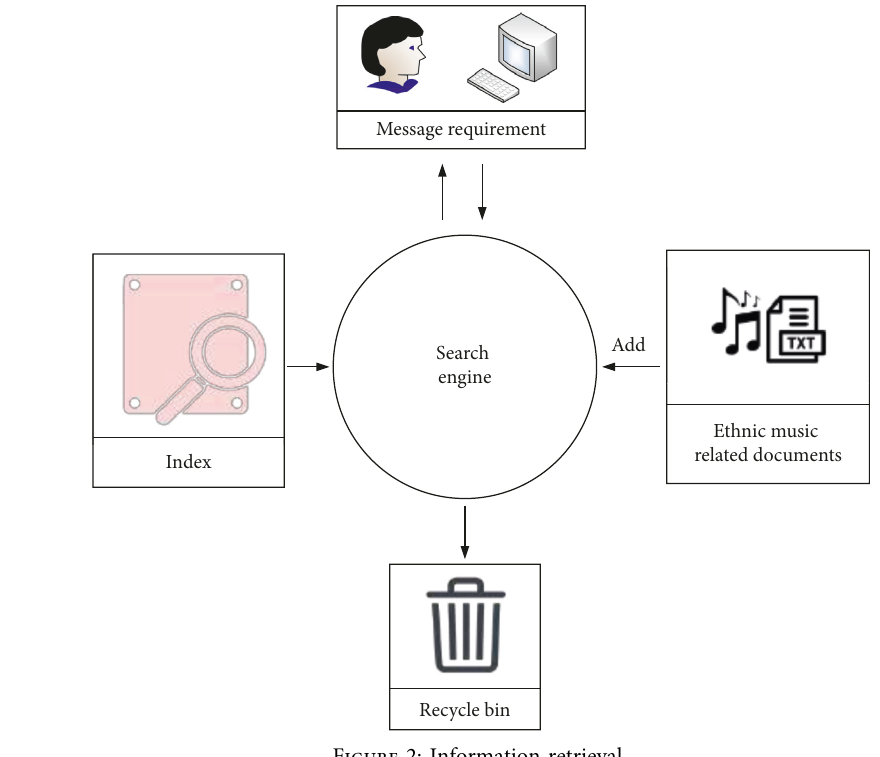
Figure 2: Information